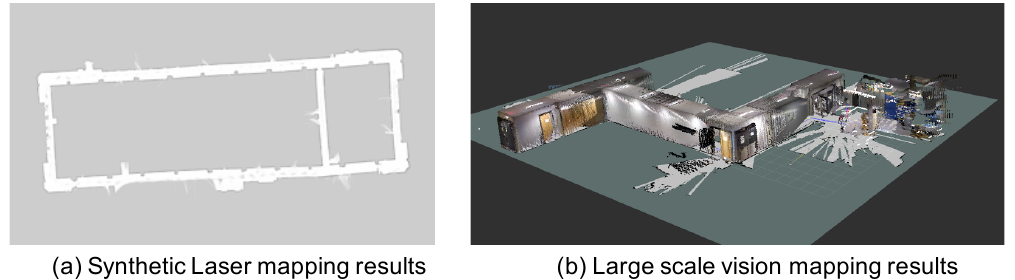
Figure 5. ( a ) The synthetic laser mapping results based on Laser and LiDAR, and ( b ) The large scale vision mapping